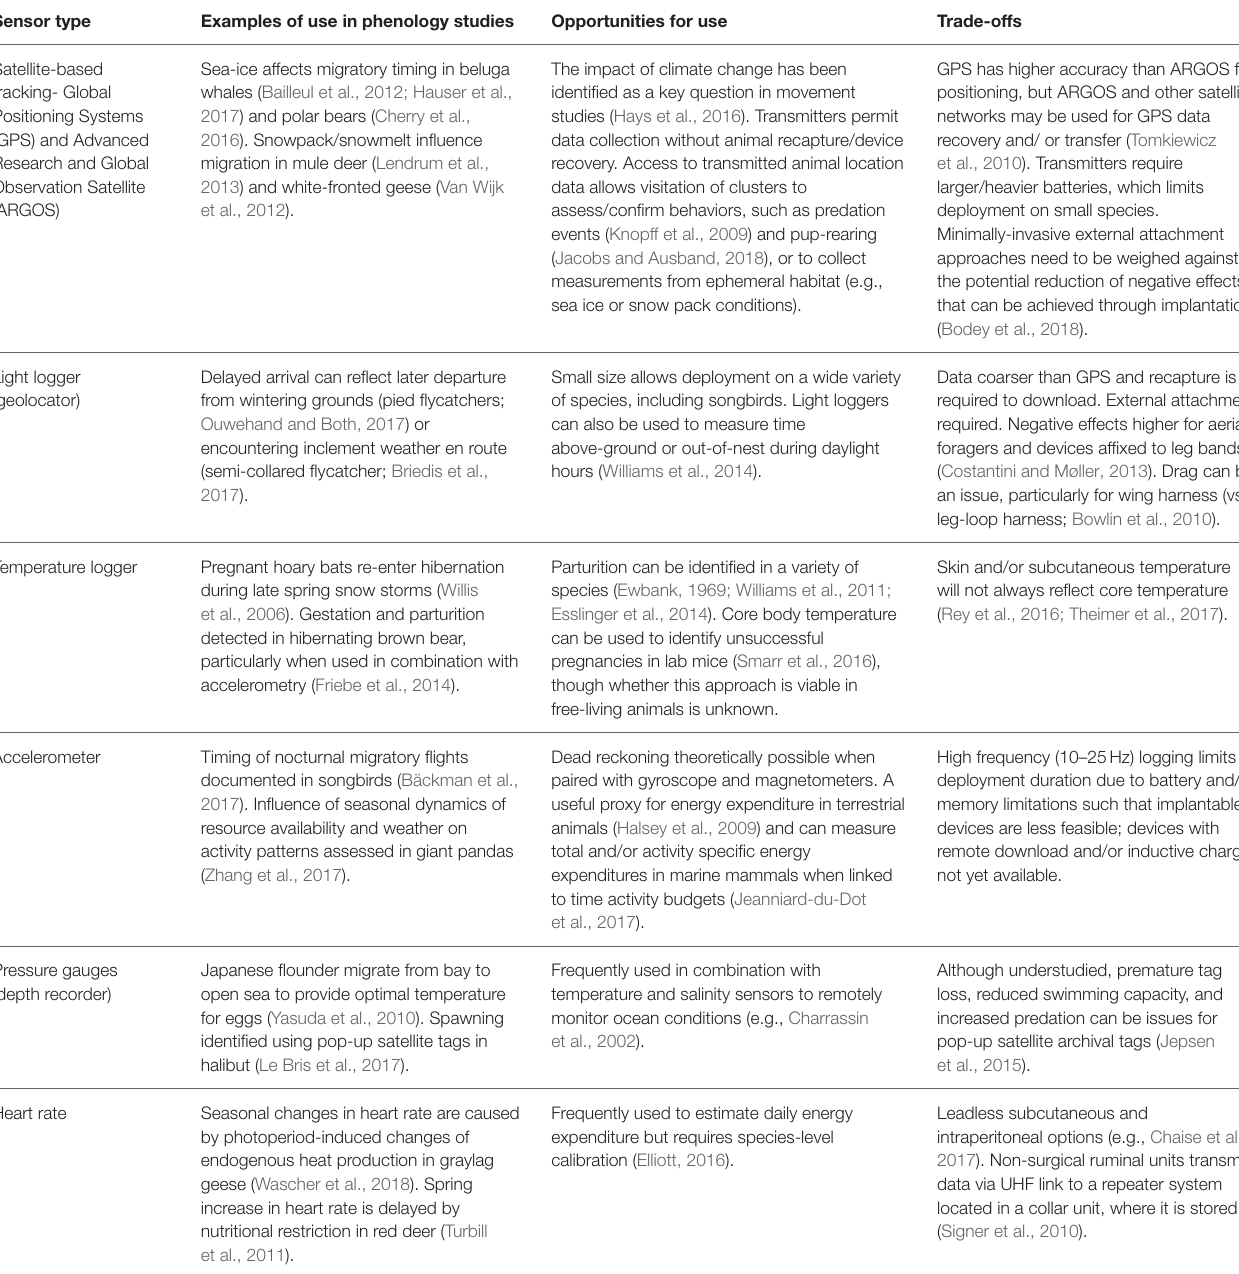
TABLE 1 | Examples of biologgers frequently used in phenological studies, the research opportunities they provide, and trade-offs to be considered in their